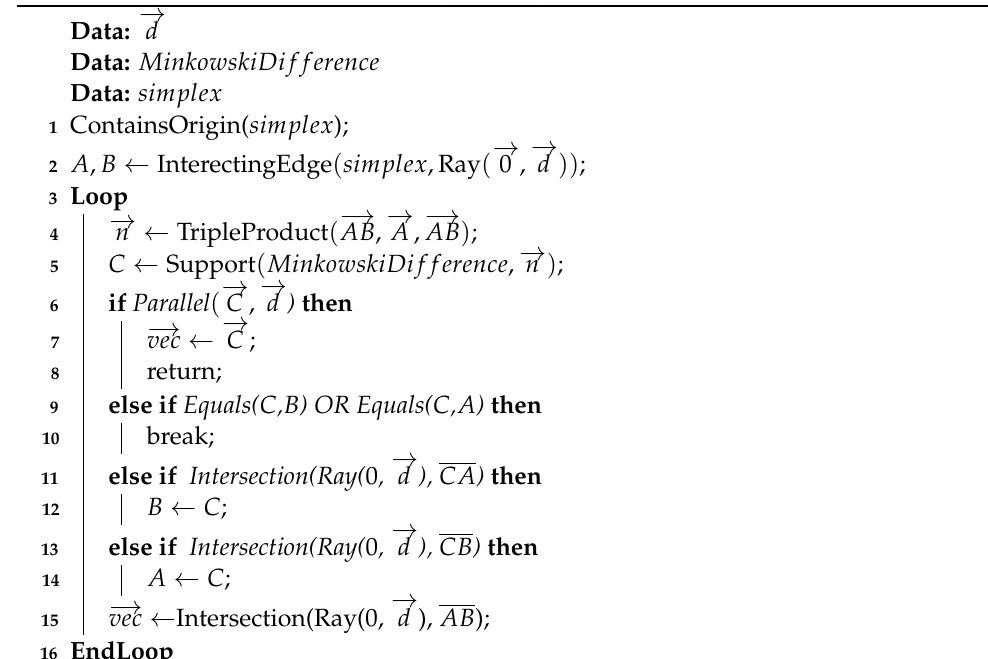
Figure 20. Illustration of penetration. Algorithm 4: Directed Extended Polytope